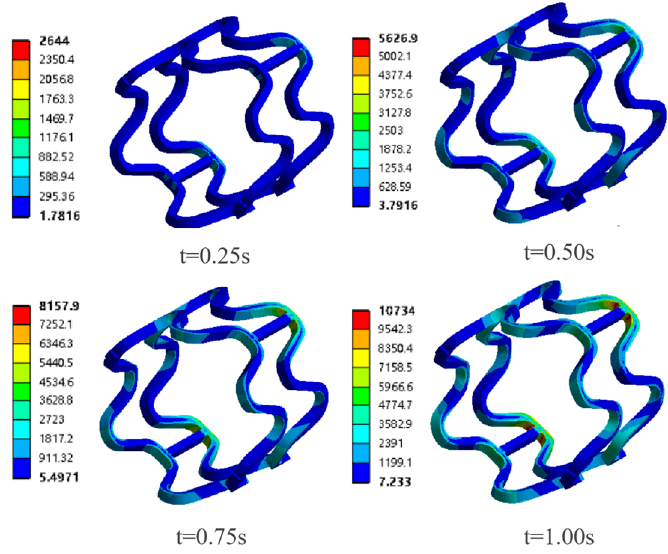
Figure 18. Distribution of wall shear stress (Pa) on the stent at different times.